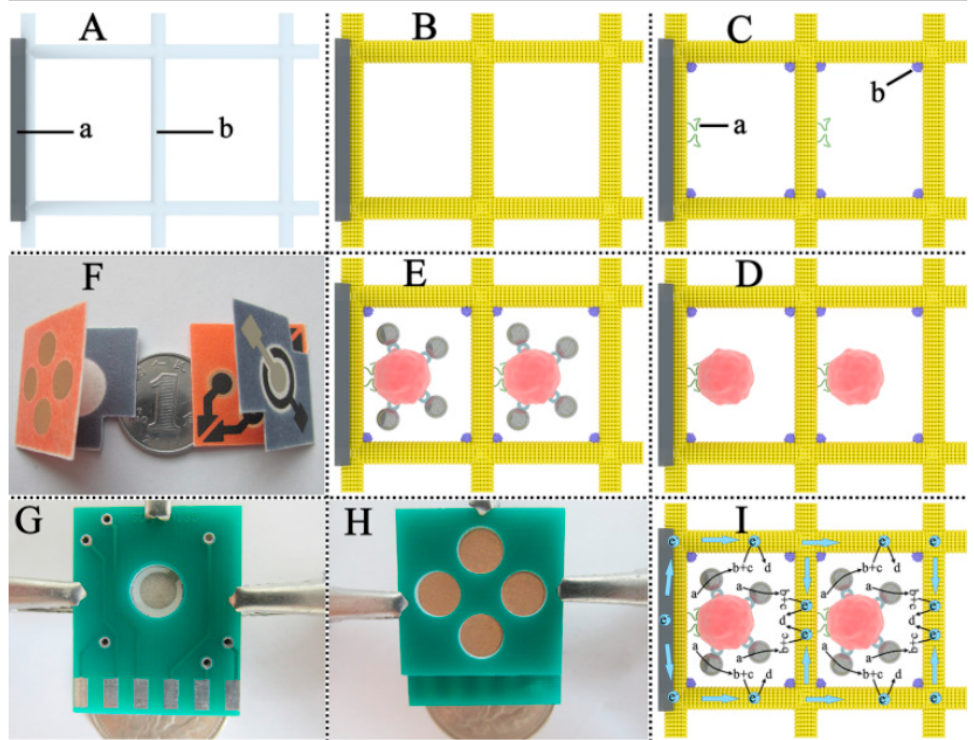
Figure 6. Paper-based microfluidic test system produced with origami technique for multiple cancer cell detection ( A ) Bare PCE: (a) SPCWE, (b) cellulose fibers in the paper cell zone (unprinted macroporous paper). ( B ) Growth of Au nanoparticles layer on cellulose fiber surfaces. ( C ) Immobilization of aptamer and blocking with BSA: (a) aptamer, (b) BSA. ( D ) Capture of cells. ( E ) Binding of AuPd@Con-A bioconjugates on cell surface. ( F ) Folded µ-PECLOC. ( G ) The folded µ-PECLOC was clamped between two circuit boards. ( H ) The reverse side of ( G ). ( I ) Schematic illustration of the ECL detection mechanism in Au-PCE: (a) H 2 O 2 , (b) O 2 , (c) K 2 S 2 O 8 , (d) 1(O 2 ) 2 ∗ . (reprinted with permission from [112]; copyright 2015, Elsevier).